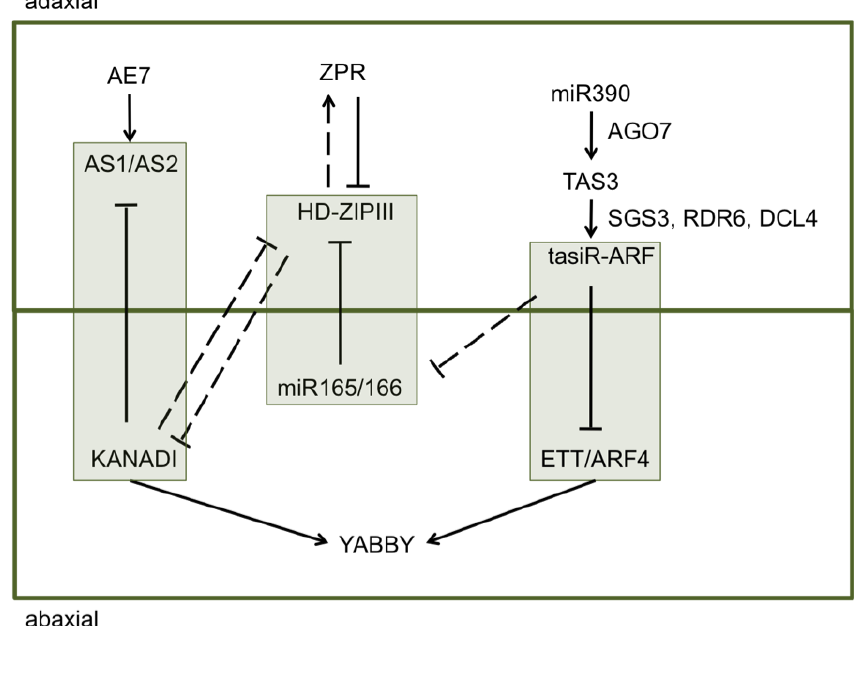
Figure 1. Adaxial–abaxial patterning in leaves is controlled by an array of transcription factors and corresponding small RNAs. Gene pathways enclosed with boxes, specify the major complexes setting dorsiventral polarity: (1) AS1/AS2-KANADI, (2) HD-ZIPIII-miR165/166, and (3) ETT/ARF4-tasiR-ARF. Solid lines indicate direct interactions while dashed lines indicate indirect interactions. Modified from Kidner and Timmermans